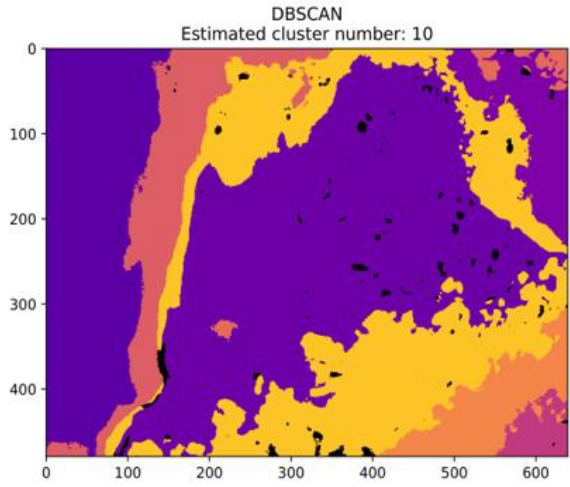
Figure 7. Clusters after running DBSCAN; each cluster is highlighted with a random color; the black clusters represent noise.